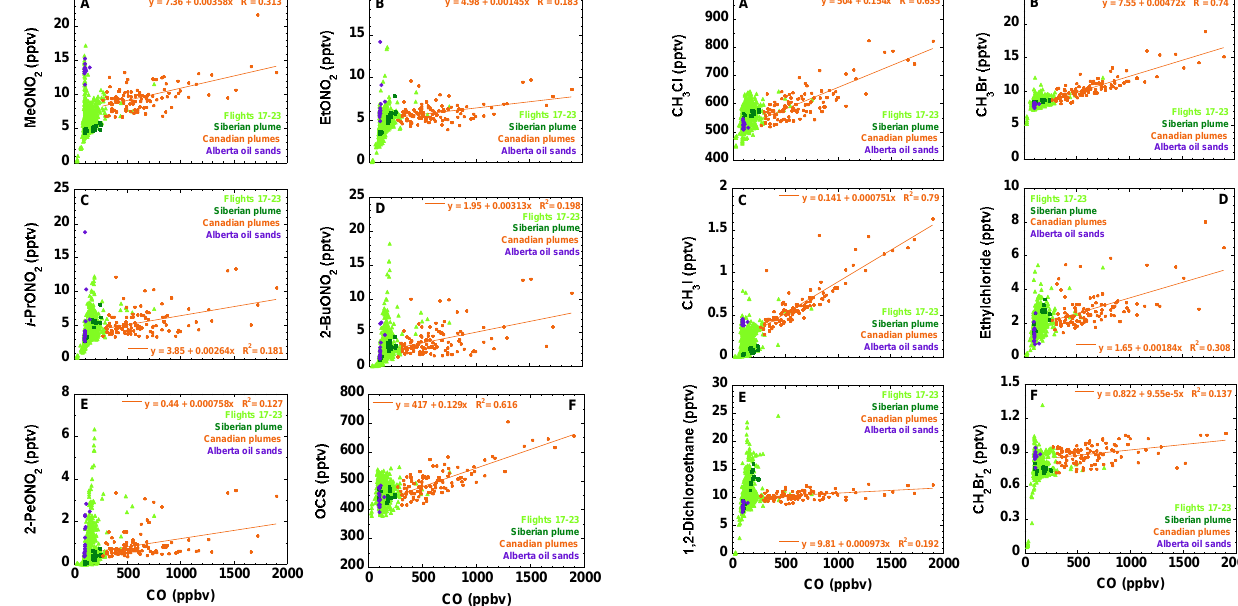
Figure 9. As in Figure 4 but for selected alkyl nitrates and OCS. Fig. 9. As in Fig. 4 but for selected alkyl nitrates and OCS.